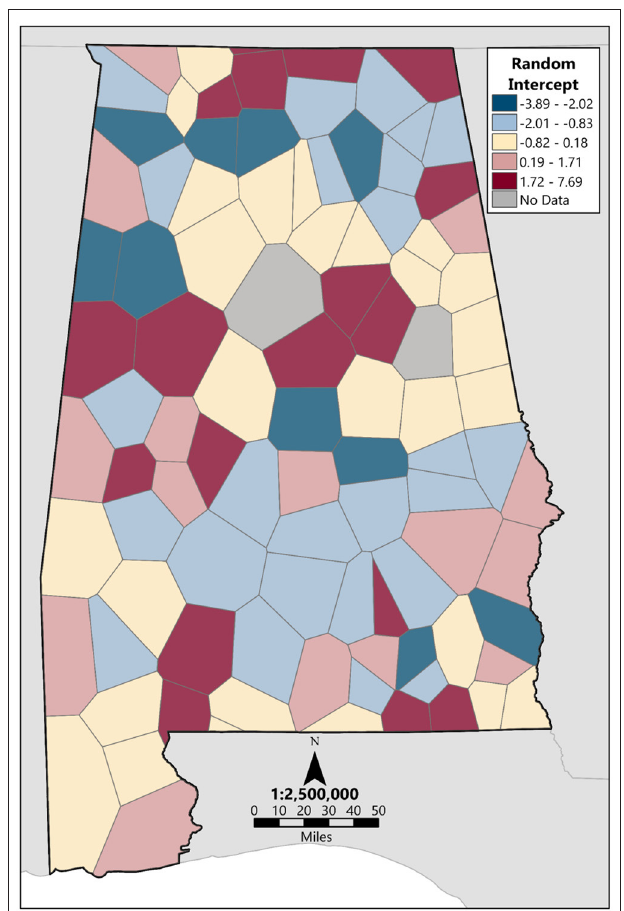
FIGURE 4 | Map of social neighborhood intercept estimates. Warm colors indicate increased likelihoods (positive intercept values) of irrigation adoption, and cool colors represent decrease likelihoods (negative intercept values) of irrigation adoption. Social neighborhoods with no data (gray) were excluded due to a lack of eligible agricultural